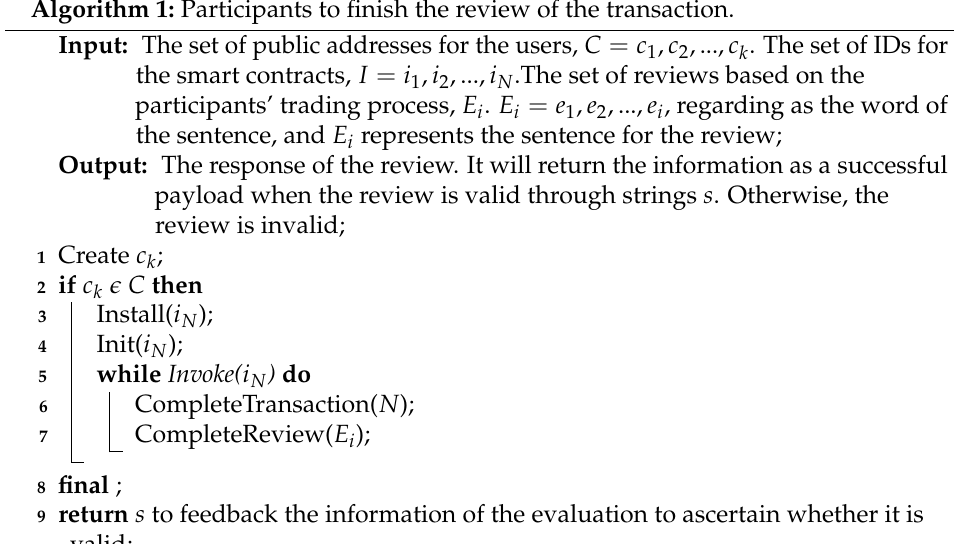
Algorithm 1: Participants to finish the review of the transaction.